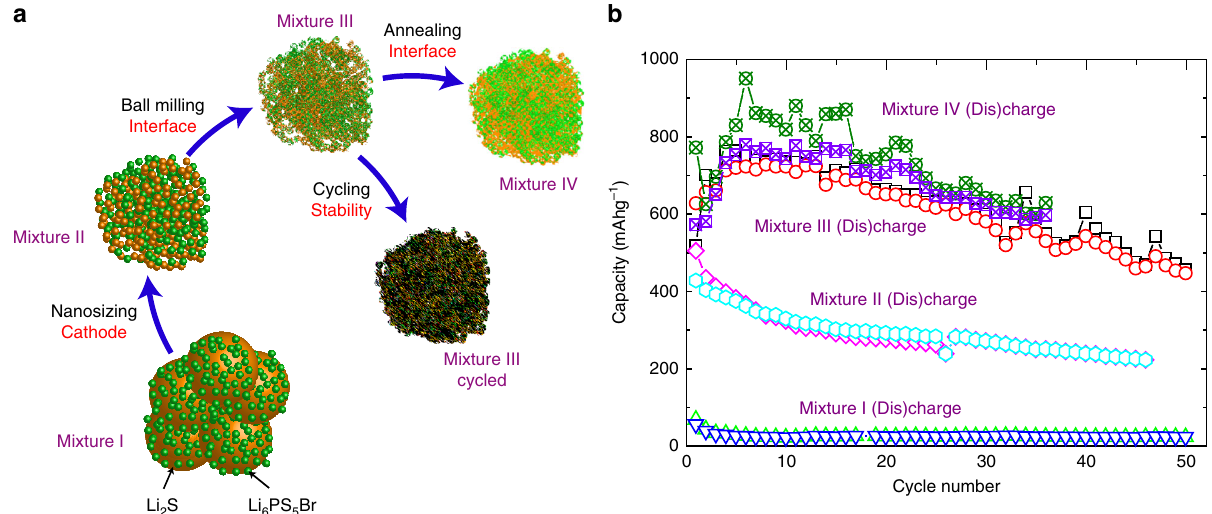
Fig. 1 Schematic representation of the different stages in solid-state battery cathode preparation and the solid-state battery capacity retention. a The different stages in cathode preparation and cycling for which the lithium-ion transport over the Li 2 S – Li 6 PS 5 Br interfaces, the charge transfer reaction is measured by 7 Li exchange NMR and electrochemical impedance spectroscopy (EIS). b The charge/discharge capacity upon cycling of the solid-state Li – S cell using micro-sized Li 2 S (mixture I in a ), nano-Li 2 S (mixture II in a ), mixed nano-Li 2 S (mixture III in a ), and annealed mixed nano-Li 2 S (mixture IV in a ) as the active material. Charge and discharge curves are shown in Supplementary Fig. 3. The charge/discharge current density was set at 0.064 mA cm − 2 (5.03 × 10 − 5 A), and the lower and upper voltage cutoff were set to 0 and 3.5 V vs.